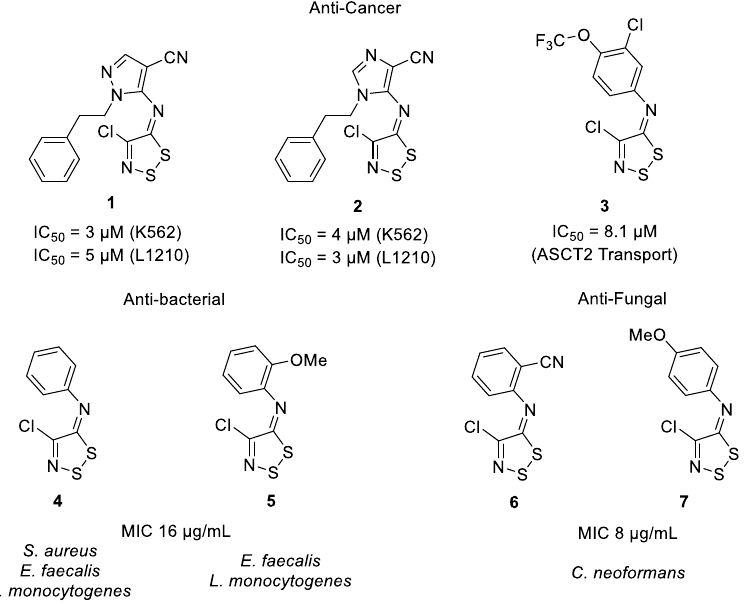
Figure 1. Examples of previously reported biologically active